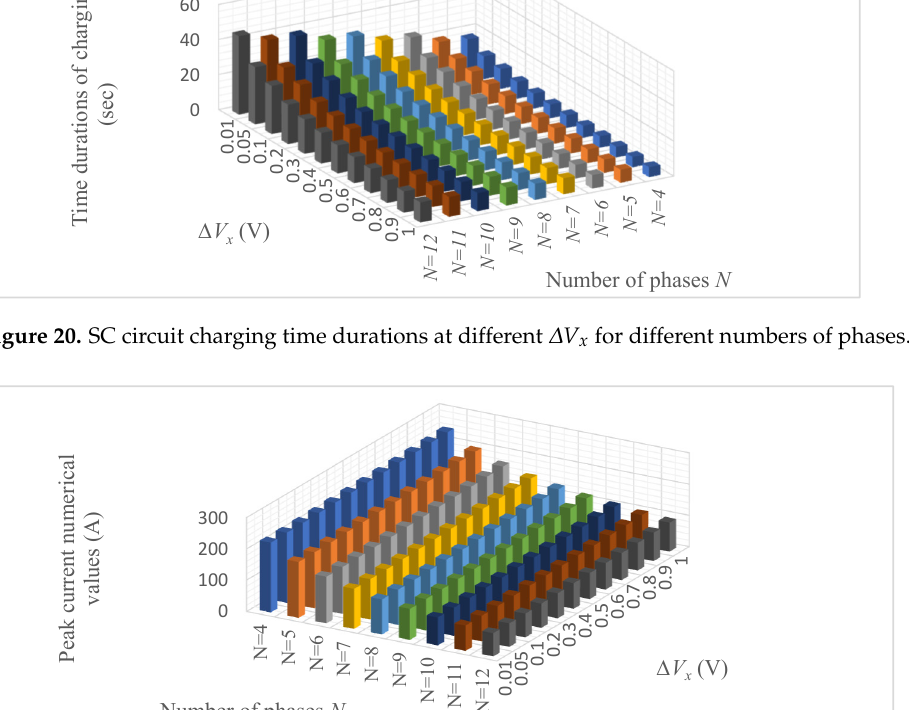
Figure 21. Peak currents of the SC circuit at different ∆ V x for different numbers of phases.